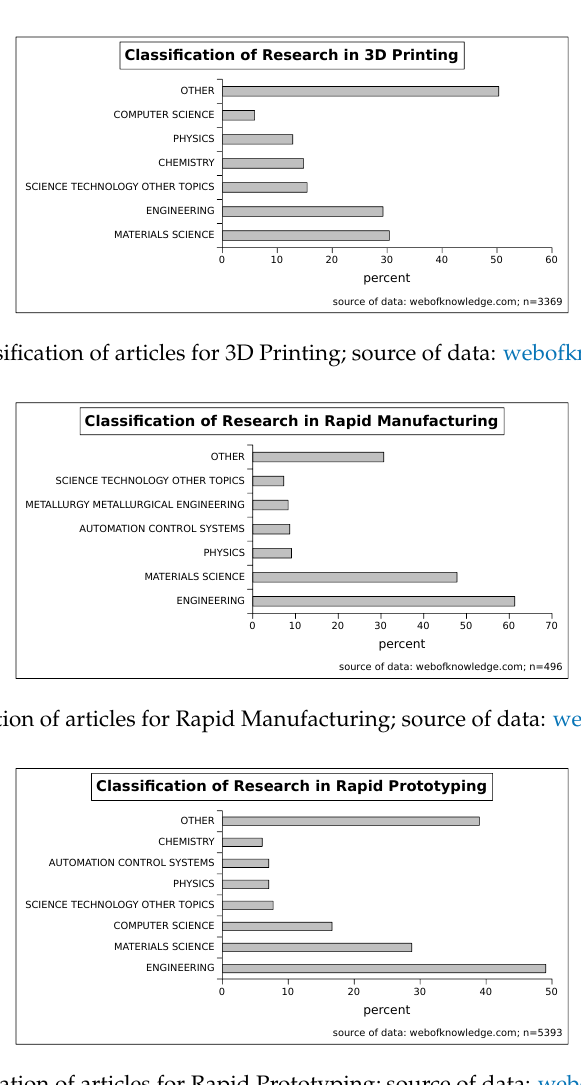
Figure 6. Classification of articles for Rapid Prototyping; source of data: webofknowledge.com.